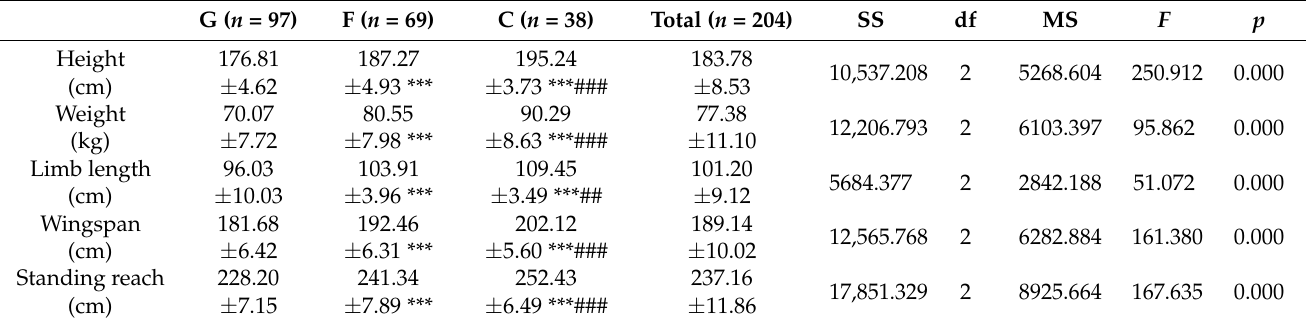
Table 2. Differences in physique according to the play